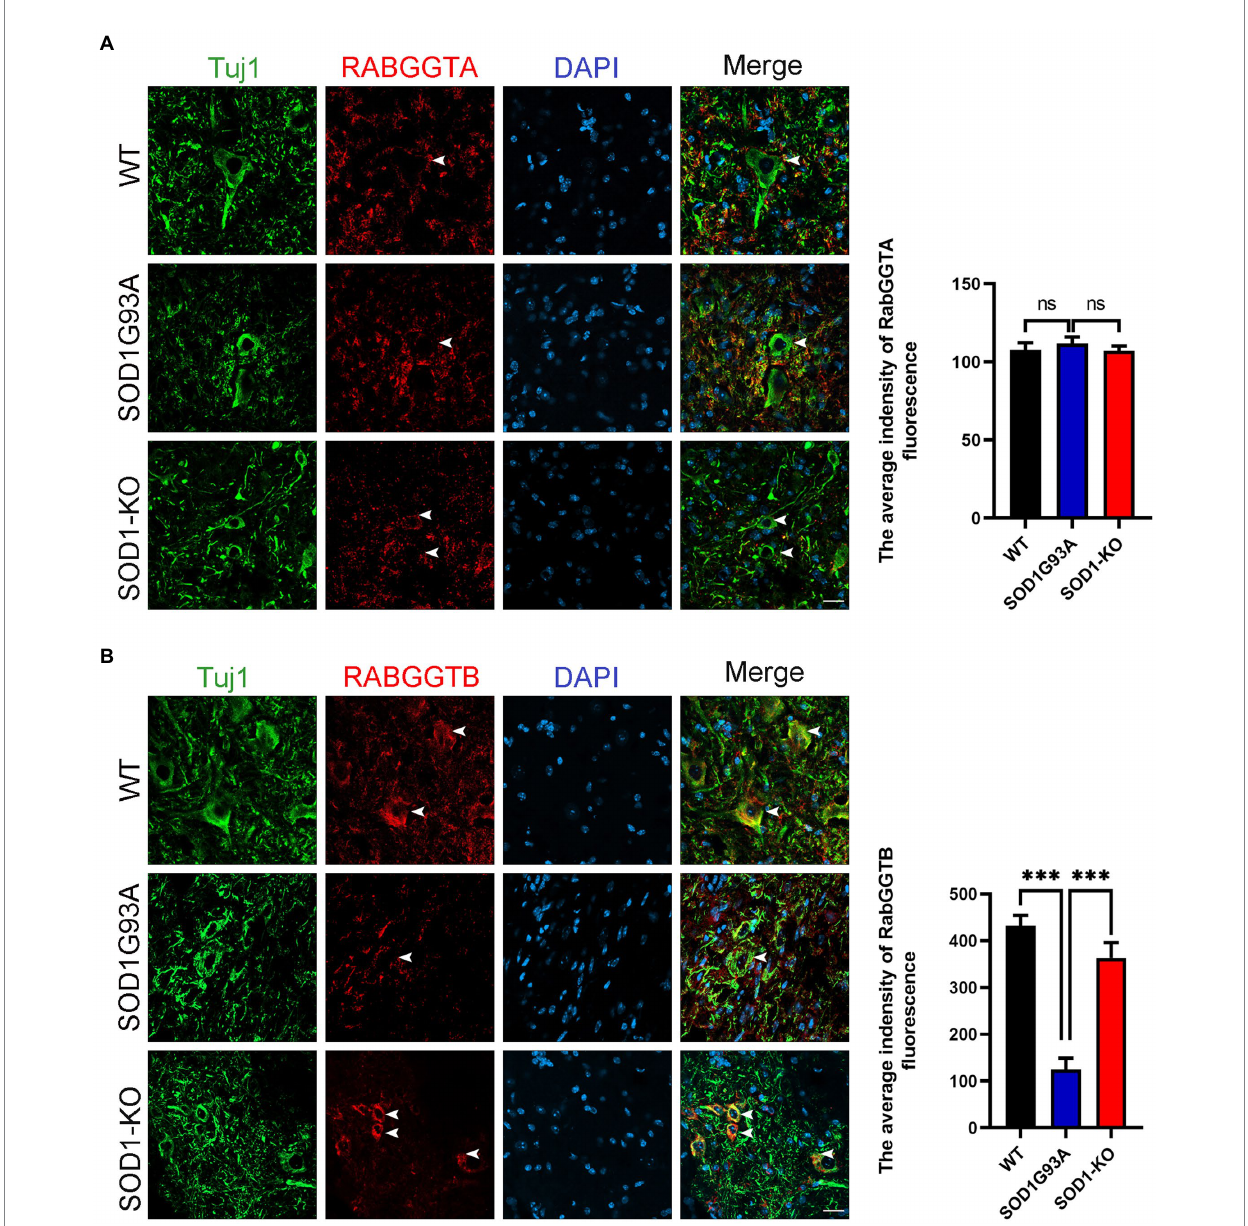
FIGURE 1 Expression of RabGGTA and RabGGTB in motor neurons of the lumbar spinal cord in different mice. (A) Immunofluorescence labeling of RabGGTA (red) in Tuj1-positive motor neurons (green) at 120 days (scale bars, 25 μ M). Quantitative analysis of fluorescence intensity of RabGGTA staining. Compared with the SOD1 G93A group, neither the WT group nor SOD1-KO group, the fluorescence intensity of RabGGTA had statistical significance. (B) Immunofluorescence labeling of RabGGTB (red) in Tuj1-positive motor neurons (green) of the lumbar spinal cord at 120 days (scale bar, 25 μ M). Quantitative analysis of fluorescence intensity of RabGGTB staining. Compared with the SOD1 G93A group, both the WT group and SOD1-KO group, the fluorescence intensity of RabGGTB had statistical significance. Data represent the mean ± SEM, n = 5 mice per group; p -values were determined using one-way ANOVA. Error bars denote the SEM. * p <0.05, ** p <0.01, *** p <0.001. ns: no